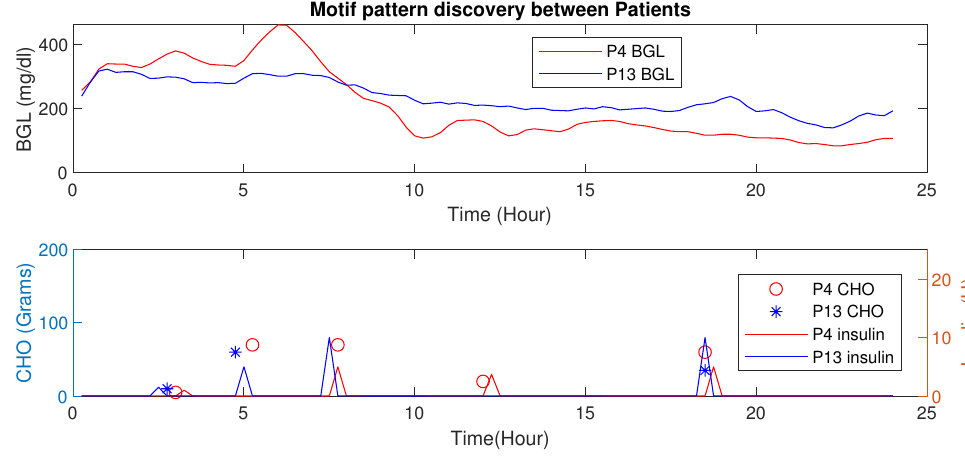
Figure 21. Time-Series Analysis: Motif Discovery between P 4 & P 13 — P 4 has a lower magnitude of BGL profile even with high average CHO and less insulin